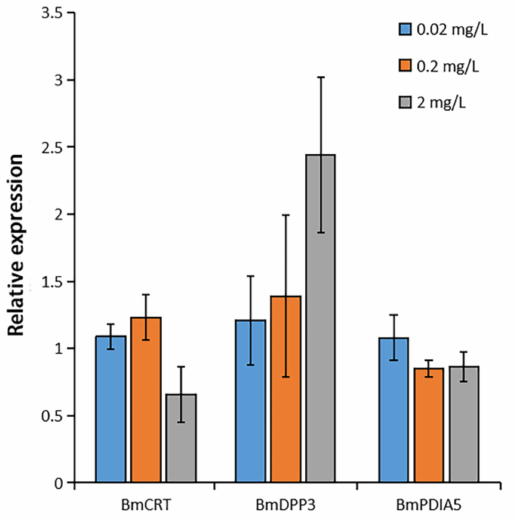
Figure 7. Expression of three genes after DA treatment of Bm12